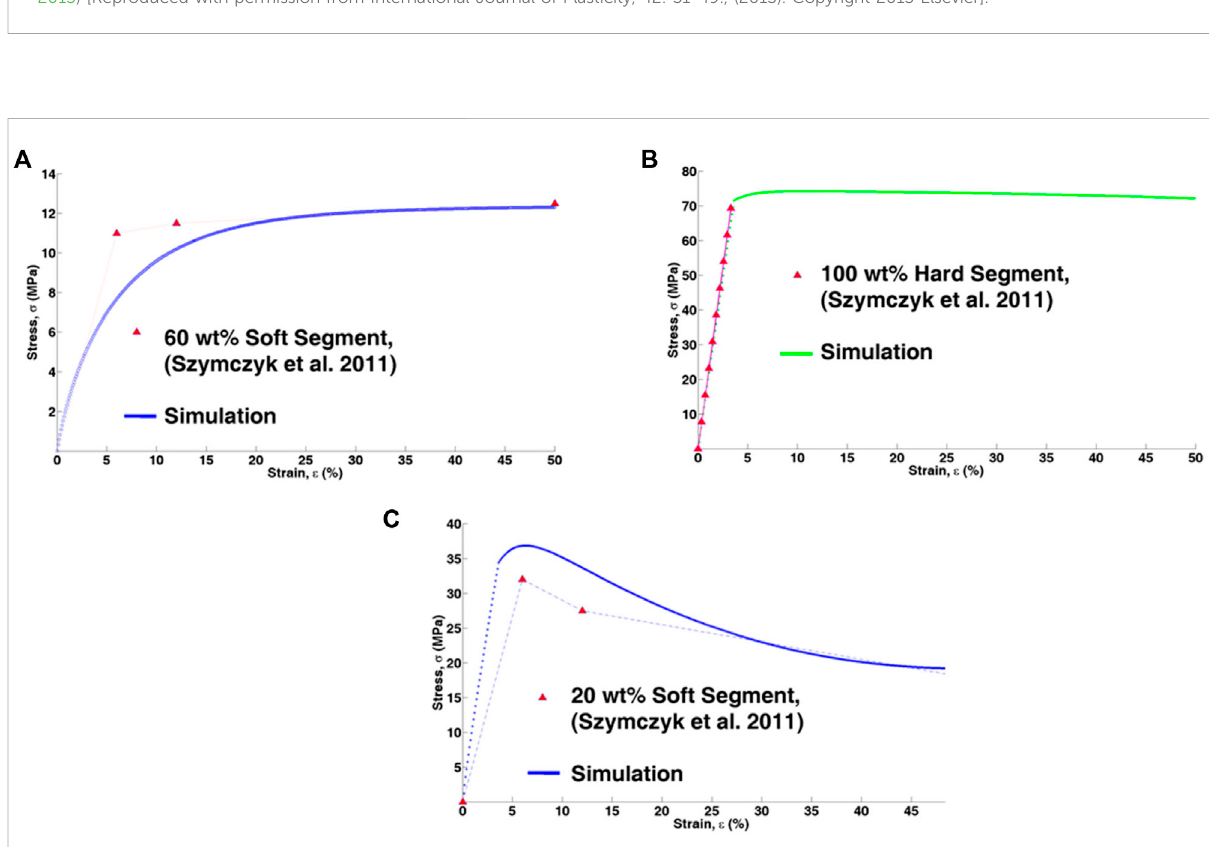
FIGURE 7 Schematic representations of (A) fi brous inclusion, (B) Penny-shape inclusion, and (C) assembled RVE in a micro length scale (Shojaei and Li, 2013) [Reproduced with permission from International Journal of Plasticity, 42: 31-49., (2013). Copyright 2013 Elsevier].